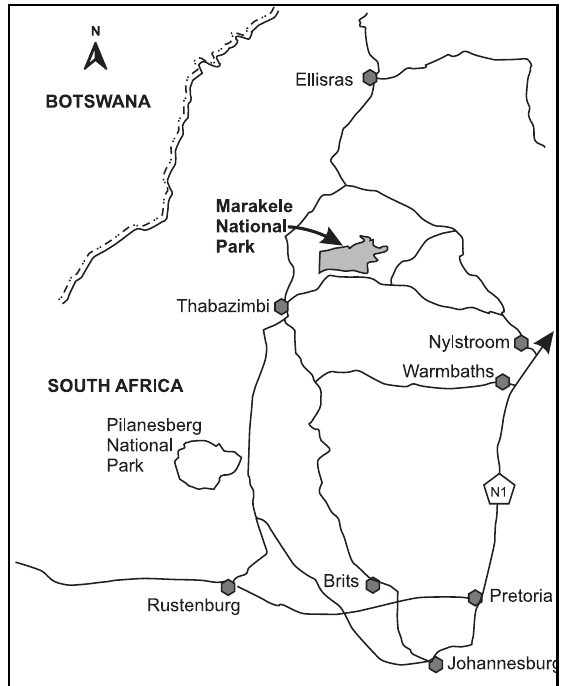
Fig. 1. Amap indicating the location of the study area in relation to